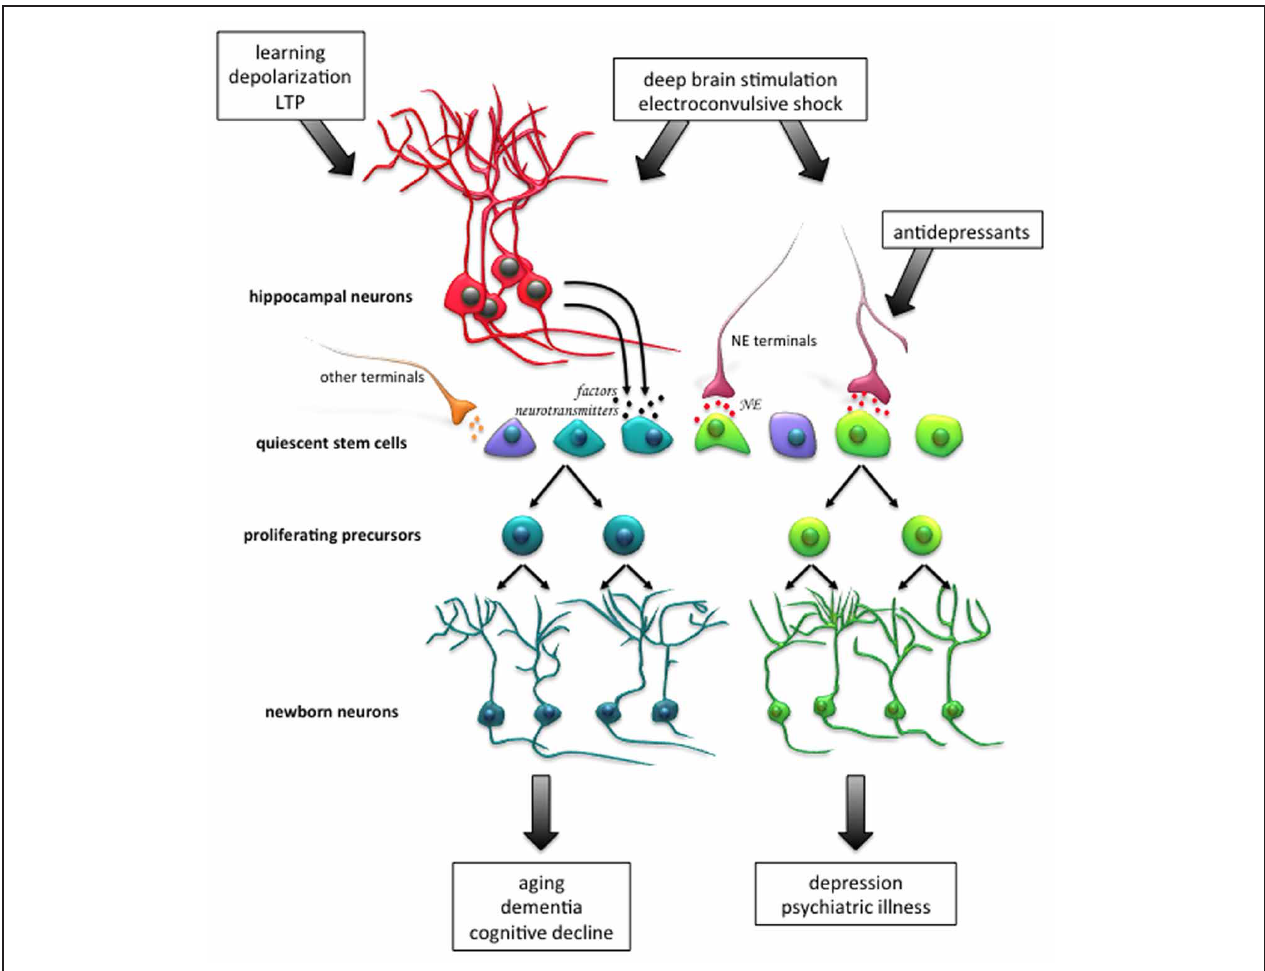
FIGURE 1 | Activation of the endogenous population of quiescent stem cells in the adult hippocampus as a therapeutic strategy for neural injury and disease. Enhancement of neurogenesis, through activation of the quiescent stem cell pool, may facilitate neuronal repair and recovery of cognitive function following aging, neuronal disorders, psychiatric conditions, and neurodegenerative diseases. For instance, neuronal activity, such as that which occurs during learning, the induction of long-term potentiation (LTP) and in vitro depolarization, potently activates quiescent stem cell proliferation. A different subpopulation of stem cells is activated following